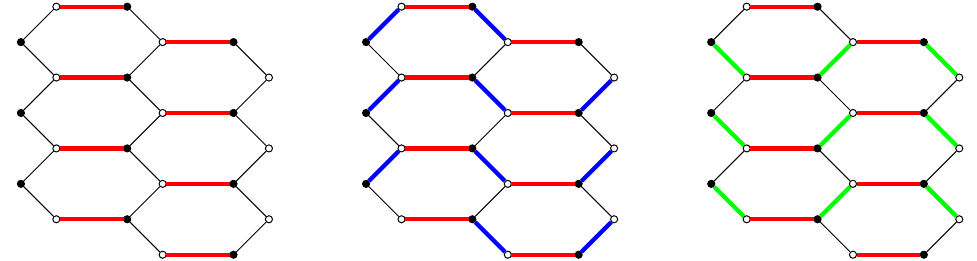
Figure 2. An illustration of a reference perfect matching (red) and loops de(cid:12)ned from two other perfect matchings (blue and